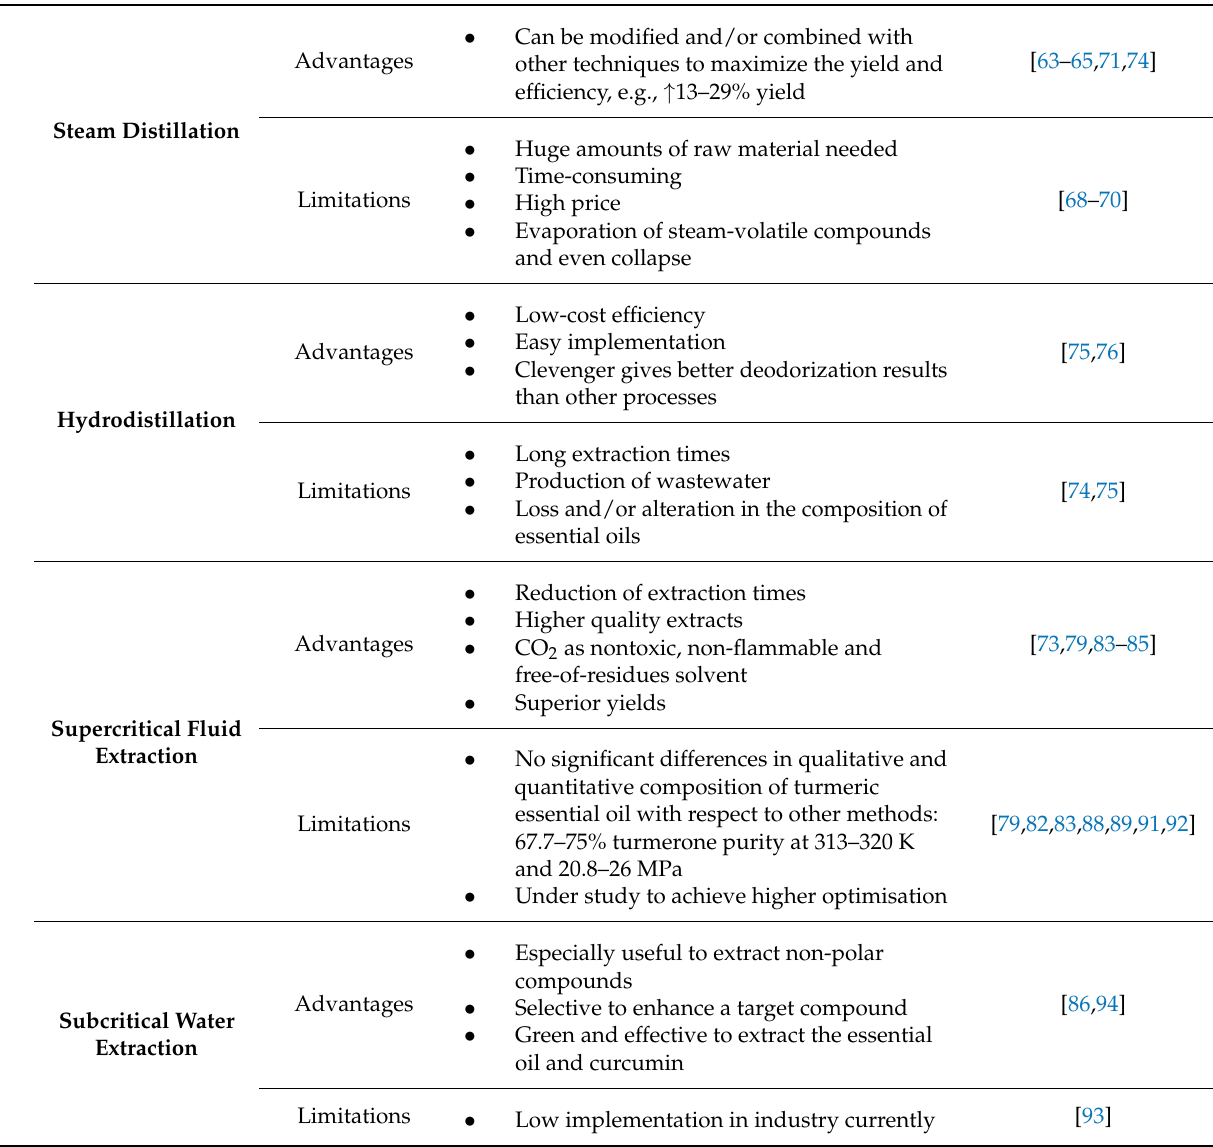
Table 1. Different extraction methods to obtain Curcuma longa essential oil: advantages and limitations. SFME: solvent-free microwave extraction, MAE: microwave-assisted extraction, HDAM: hydrodistillation assisted by microwave, SDAM: steam distillation assisted by microwave, VMHD: vacuum microwave hydrodistillation and MHG: microwave by hydrodiffusion and gravity. ↑ : Increase, ↓ :